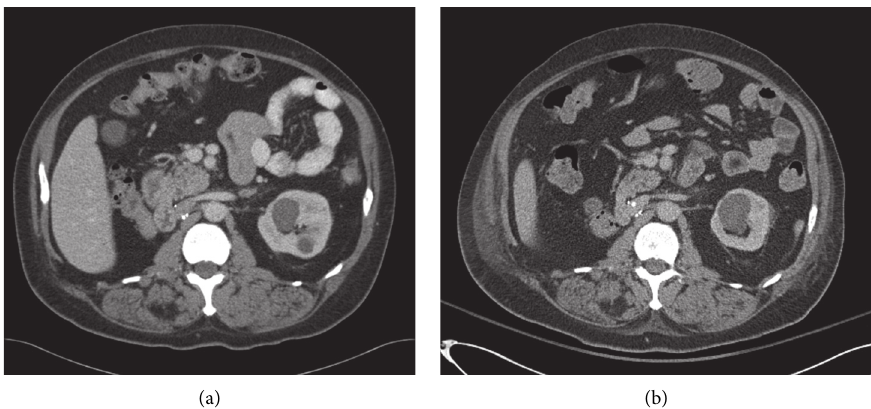
Figure 1: Contrast-enhanced CTscan of the abdomen (a) two years before transplant and (b) five months after transplant. (a) Left kidney showing a 3.1 × 2.6cm, nonenhancing, cystic lesion at the upper pole. (b) Enlarged and minimally enhancing 3.3 × 3.8 cm mass in the upper pole of the left kidney suspicious for renal cell cancer (white